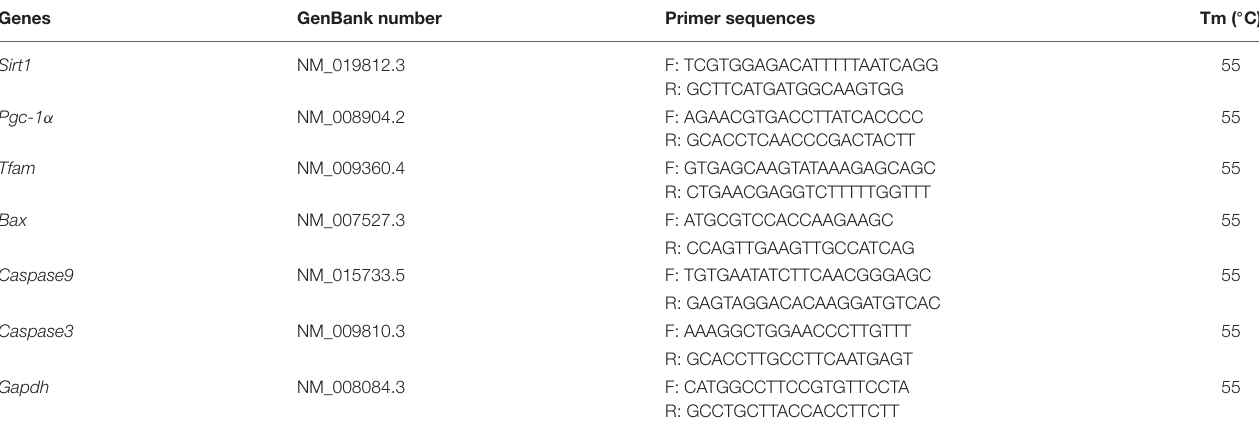
TABLE 1 | The specific primers used for Q-PCR in this study. Genes GenBank